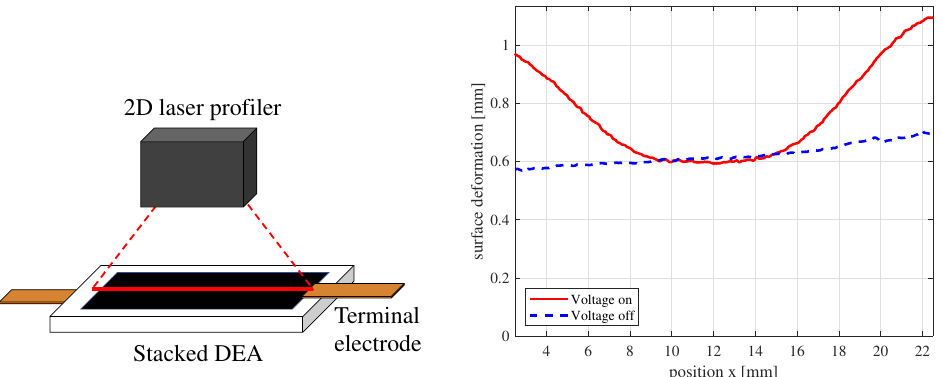
Figure 3. Schematic of measuring the surface deformation by a 2D laser displacement sensor ( left ) and experimentally measured surface deformation ( right ). The DEA was placed flat on a smooth flat table. The central part did not become thinner than expected, but the part away from the center became thicker. The electrode is located from about 4 mm to 20